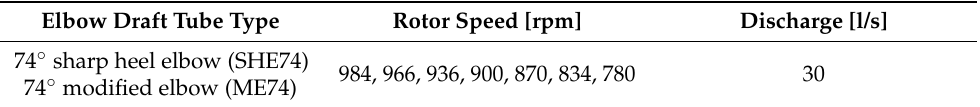
Figure 3. Variable operating conditions delivered by the swirling flow apparatus: the dimensionless flux of the moment of momentum ( m ) versus the discharge coefficient ( q ). All seven operating points selected in this experiment are marked with (cid:4) . Table 1. Variable operating conditions obtained with a magneto-rheological